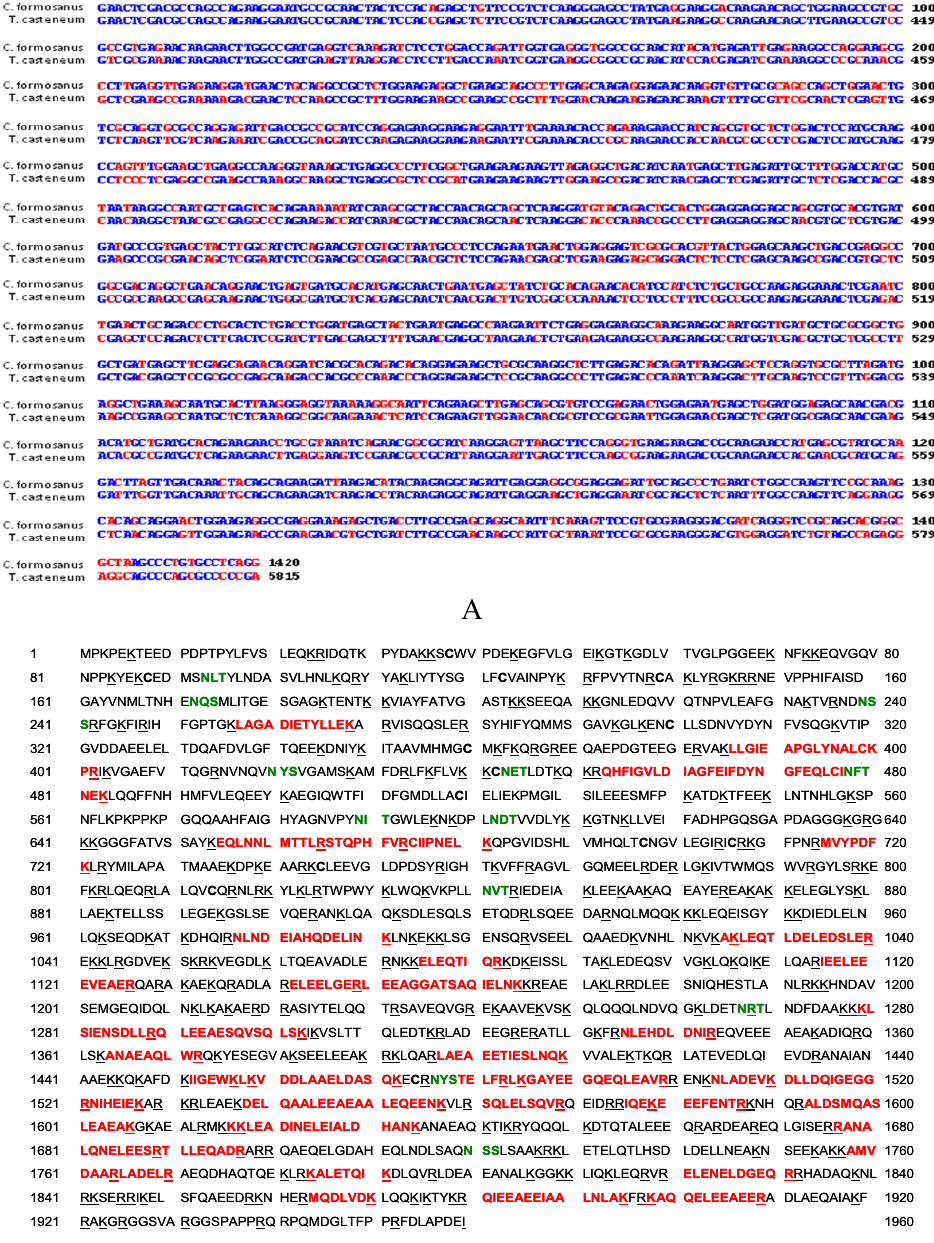
Figure 1. Myosin cDNA and protein sequence ( A ) Sequence of the Formosan termite ( Coptotermes formosanus ) and red flour beetle ( Tribolium castaneum ) myosin heavy chain mRNA show 78% identity within the recovered segment. Partial C. formosanus myosin heavy chain cDNA sequence (1,420 bp, top strand) was aligned with residues 4396 (cid:177) 5815 of the predicted T. castaneum myosin heavy chain I transcript variant 3 mRNA (bottom strand, full-length 1-6248, XM_001813544) using the Wilbur-Lipman DNA alignment program with a 20 residue window and a gap penalty of three. Conserved residues are shown in blue and mis-match residues are shown in red. ( B ) The termite peptides matching T. castaneum myosin heavy chain peptides with high confidence are shown in red, cysteine residues in bold, and potential glycosylation sites (NXX) are shown in